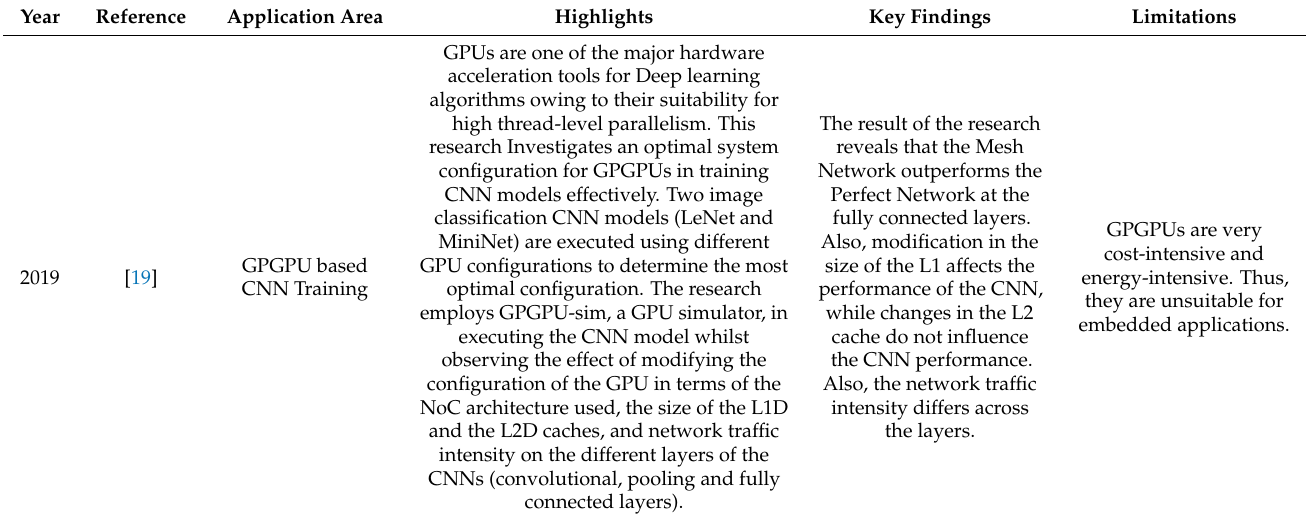
Table 20. Deep learning training in general purpose graphic processing units